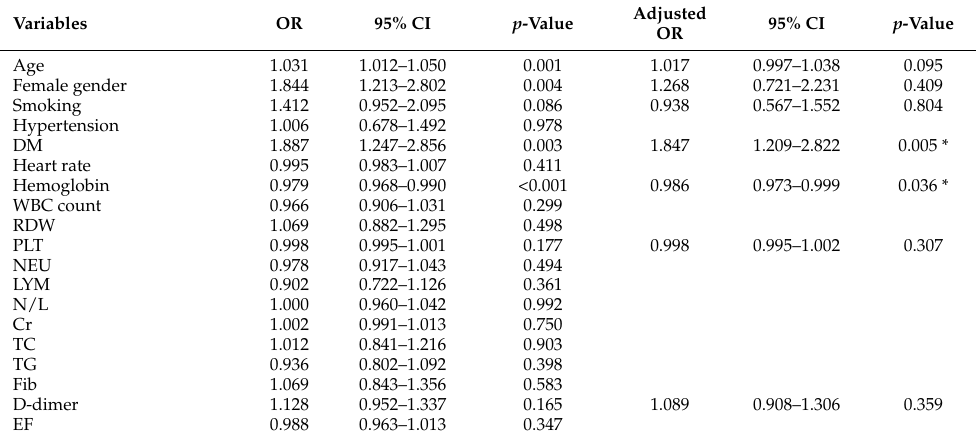
Table 3. Logistic regression analysis of predictors of no-reflow in all subjects.